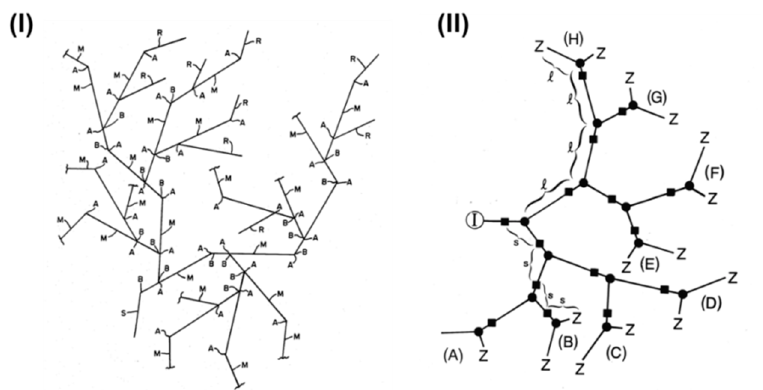
Figure 3. ( I ) Two-dimensional projection of a monodendron with asymmetrical branch junctures (i.e., Denkewalter topology) as it appeared in the Denkewalter patent [17]. ( II ) Two-dimensional projection of a Denkewalter monodendron with surface branch cells (A–H). The (s) and (l) notations are the short and long segment length, respectively. Reprinted with permission from [10]. Copyright 1990 John Wiley & Sons.